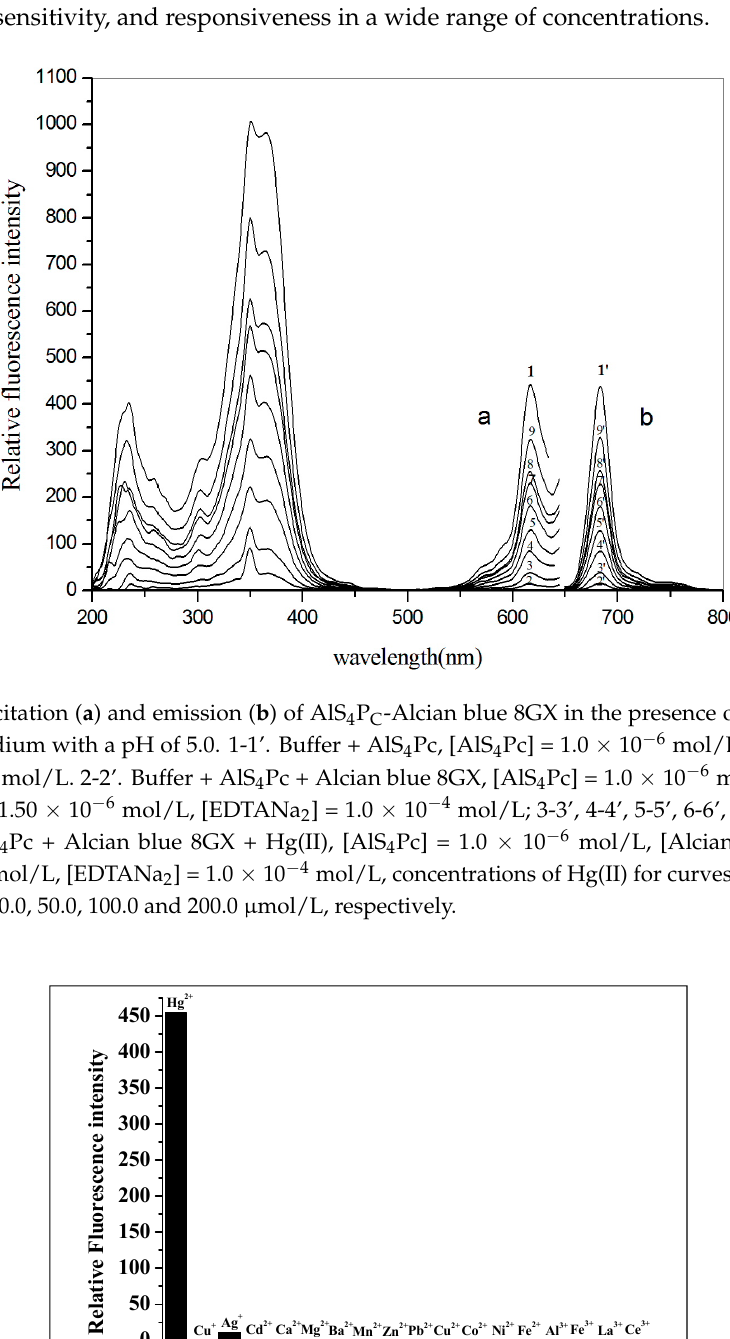
Figure 4. Comparison of recovery effect on the fluorescence of AlS 4 P c -Alcian blue 8GX in the presence of different metal ions in an aqueous medium with a pH of 5.0 containing EDTA. The concentration of AlS 4 Pc was 1.0 × 10 − 6 mol/L, Alcian blue 8GX was 1.50 × 10 − 6 mol/L, and EDTANa 2 was 1.0 × 10 − 4 mol/L. The concentration of all of the metal ions added was 1.0 × 10 − 4 mol/L.